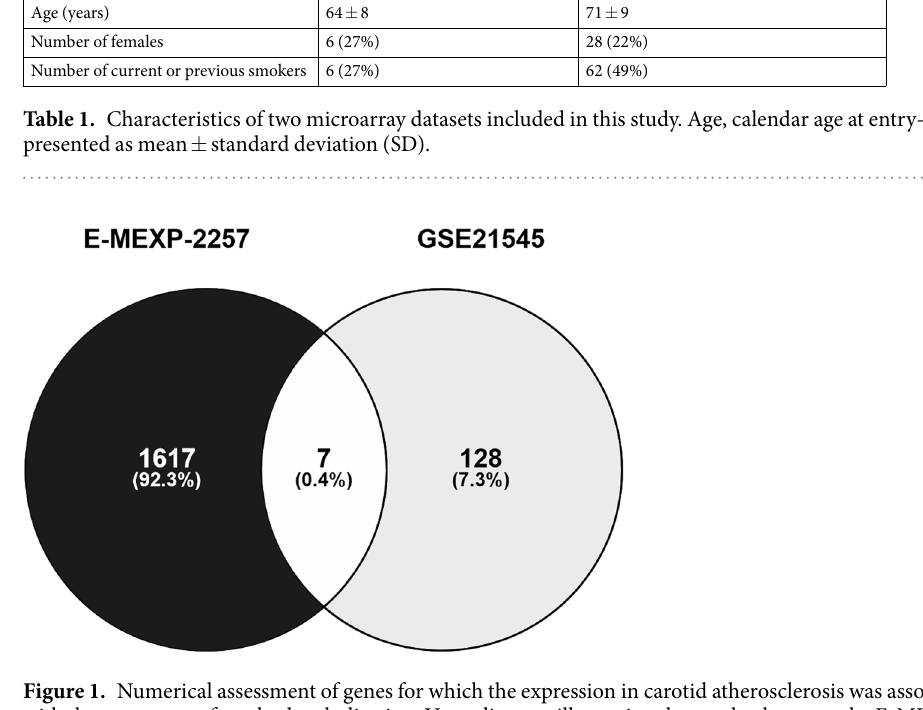
Figure 1. Numerical assessment of genes for which the expression in carotid atherosclerosis was associated with the symptoms of cerebral embolization. Venn diagram illustrating the overlap between the E-MEXP-2257 and GSE21545 microarray datasets profiling differentially expressed genes within carotid plaque biopsies. Samples obtained from patients with symptoms of cerebral embolization were compared with those of patients without the symptoms ( ≥ 1.15-absolute fold difference, P < 0.05 without mathematical correction for multiple comparisons calculated with non-parametric Mann-Whitney Results Datasets characteristics.